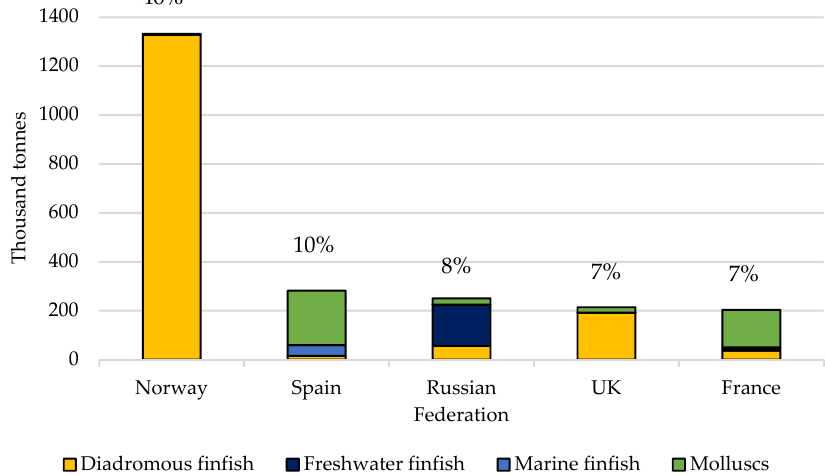
Figure 2. Aquaculture fish production of the main producing countries in Europe in terms of volume: percentage of European total aquaculture production in 2018. Values above each column represent the aquaculture production of each country in terms of percentage of the total European aquaculture production in 2018. Data source: FAO, 2020.